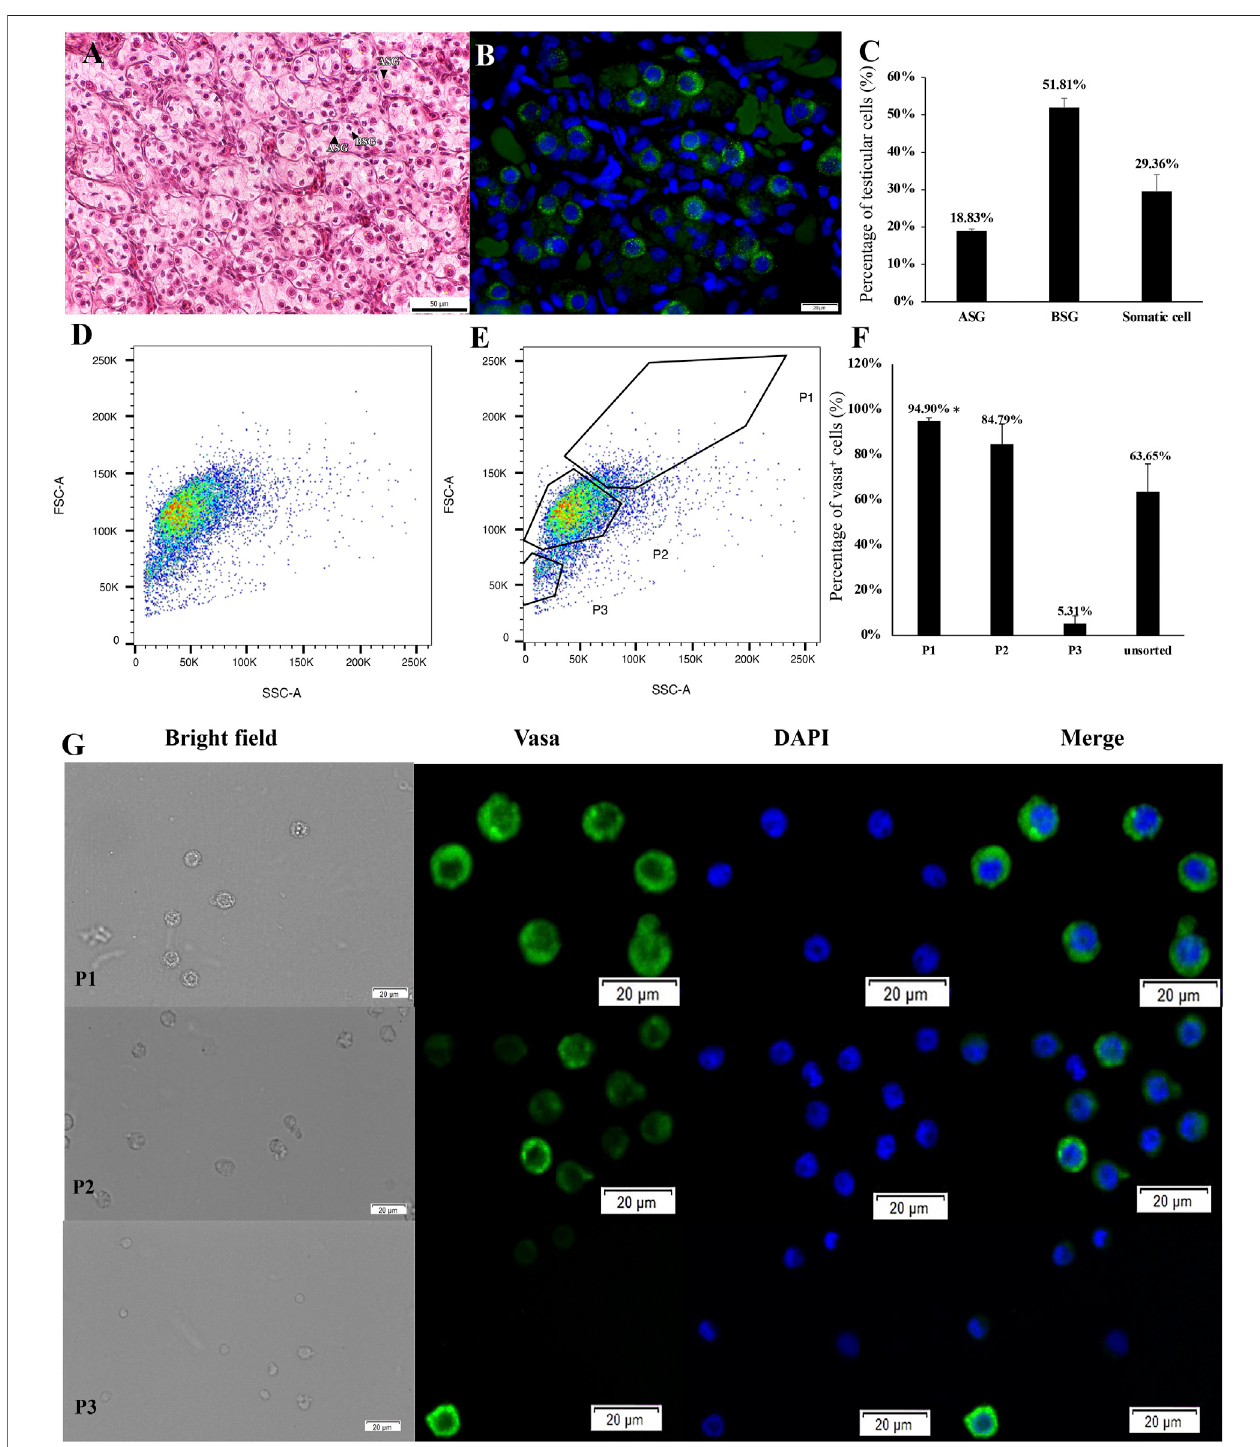
FIGURE 2 | Histological observation and light scattering property-dependent fractionation of 18 month-old sterlet testes. (A) Testes sections stained with hematoxylin and eosin (HE). (B) Testes sections stained with anti-vasa antibody. (C) The proportion of various germ cell populations and somatic cells in testes. ASG, type A spermatogonia; BSG, type B spermatogonia. (D, E) Bivariate histograms of fl ow cytometry data from dissociated testicular cells prepared from 18 month-old sterlets. Gates P1-P3 were set on the histogram and used for cell sorting. (F) Vasa-positive rates of sorted cells in gates P1-P3 and unsorted live cells [mean ± standarddeviationofmean(SD)].Meanswithanasteriskindicateasigni fi cantdifference(n (cid:1) 6, p < 0.05). (G) MicroscopicobservationofsortedcellsusinggatesP1-P3. (H) Cells from gates P1-P3 stained with anti-vasa antibody and DAPI.